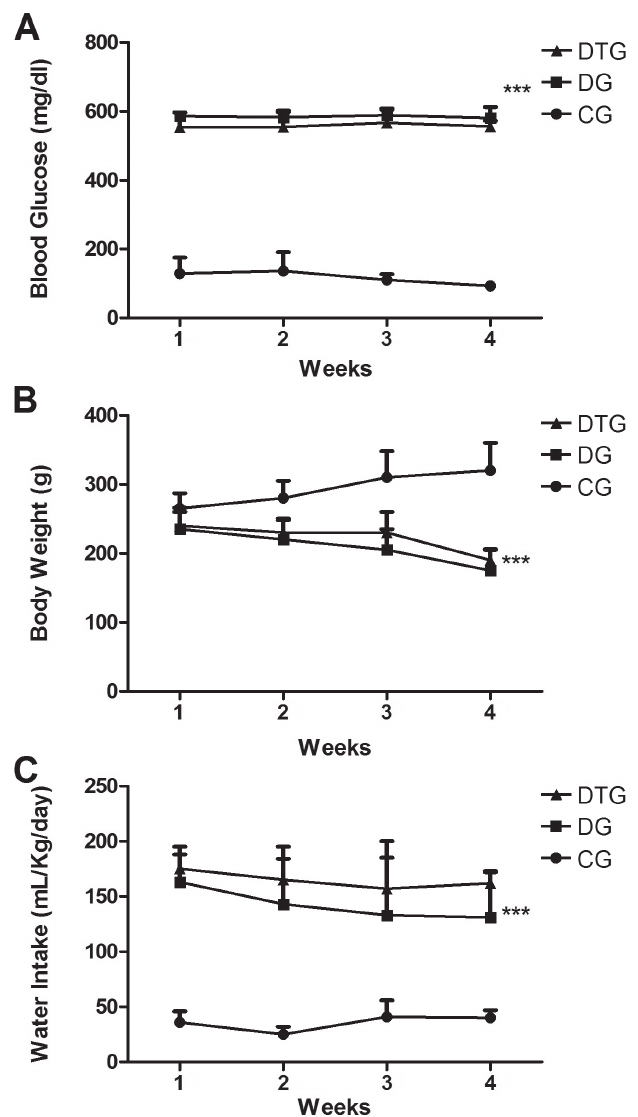
FIGURE 2 - Evaluation of fasting plasma glucose (A), body weight (B) and water intake (C) in groups CG (control), DG (diabetic) and DTG (diabetic Cissampelos sympodialis treatment) during the experimental 4-weeks protocol. Data appear as mean ± SD ***p<0,001 in relation to CG versus